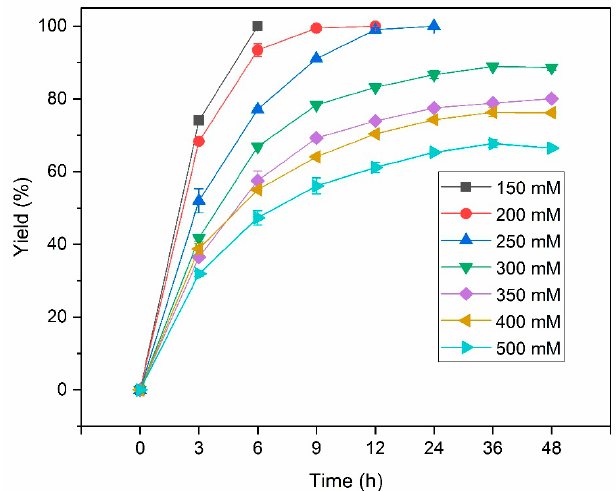
Figure 3. Synthesis of HMFCA under optimized conditions. Reaction conditions: HMF of the Figure3. SynthesisofHMFCAunderoptimizedconditions. Reactionconditions: HMFofthedesignated designated concentration, 0.2 g/mL microbial cells, 5 mL phosphate buffer (100 mM, pH 7.0), 35 ° C,